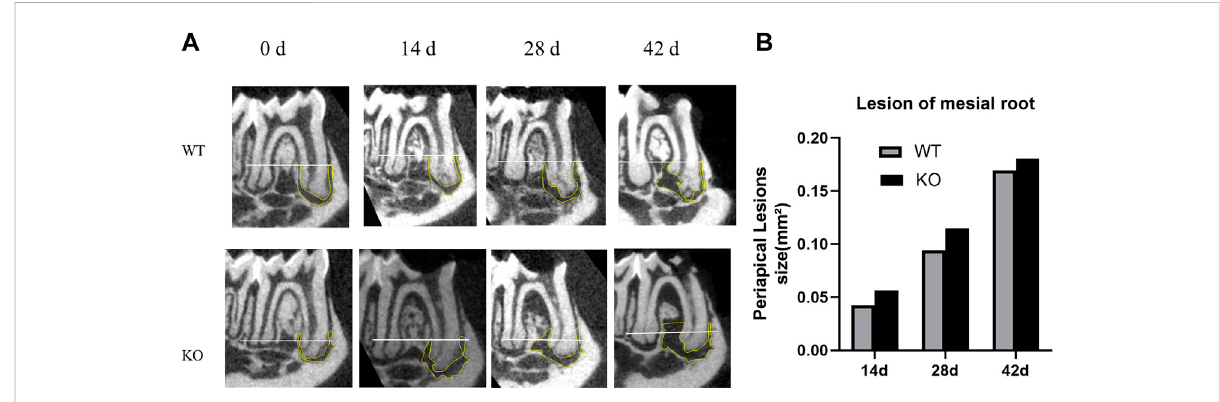
FIGURE 3 Micro-computed tomography analysis of periapical lesions after root canal treatment in mice. (A) Representative images of tooth in the KO group and WT group. White line passing through the apical third of the mesial root canal is denoted as the coronal limit of the periapical lesion. (B) Comparison of the differences in the size of periapical lesions in the mesial canal (* p > 0.05 indicates no signi fi cant difference; Mann – Whitney test). Data represent the median of each